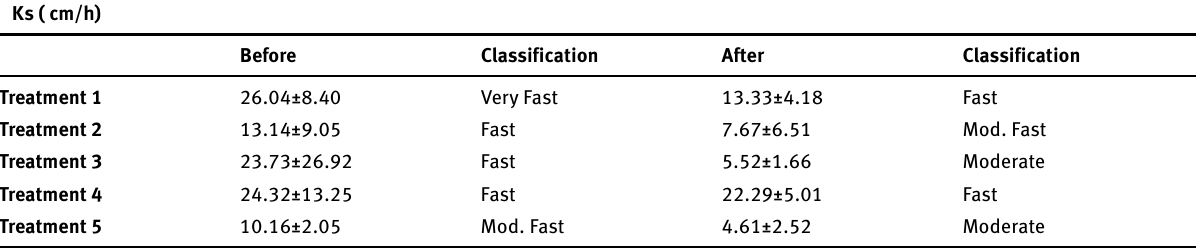
Table 2: Comparison and classification of treatments mean (± standard deviation) saturated hydraulic conductivity (Ks), before and after tillage operations, at 0-0.05 m soil